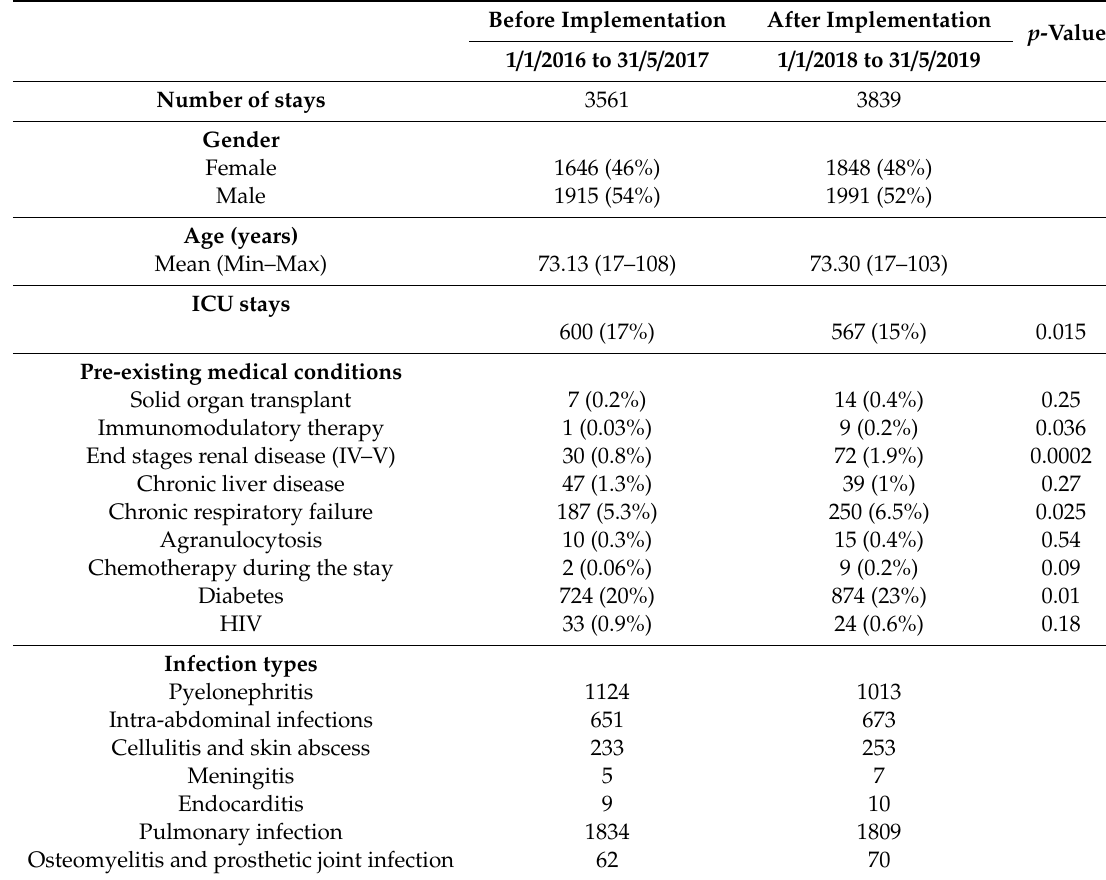
Table 1. Demographic characteristics and pre-existing medical conditions of patients with a diagnosis of deep infection before and after implementation of the antibiotic stewardship program in the eight wards that benefited from all types of